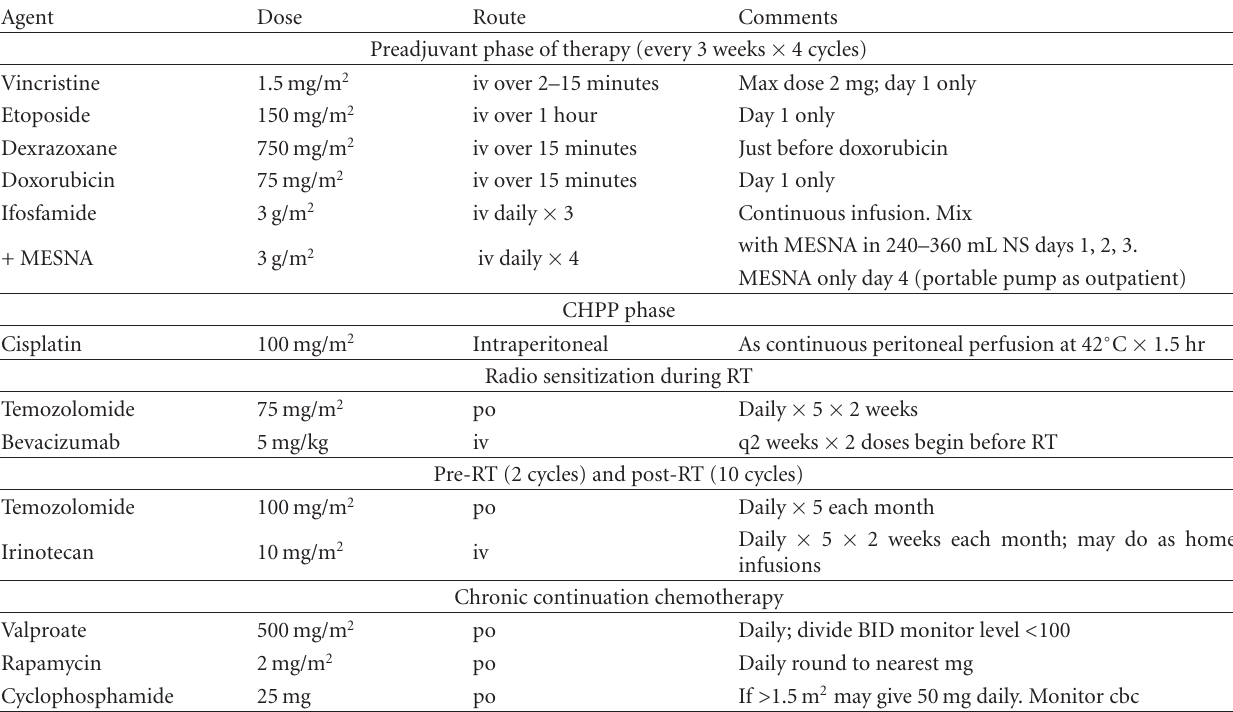
Table 1: Outpatient DSRCT chemotherapy: doses and